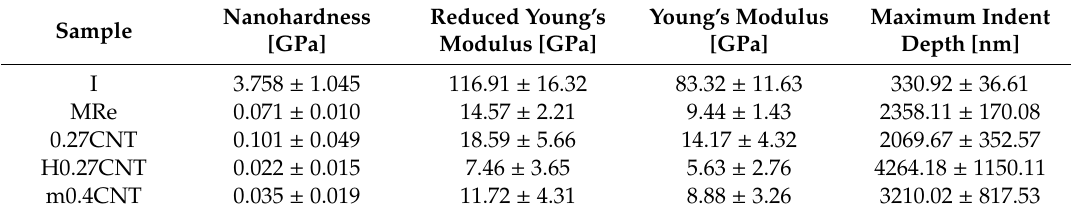
Table 4. Mechanical properties and maximum indent depth for the substrate and achieved coatings.